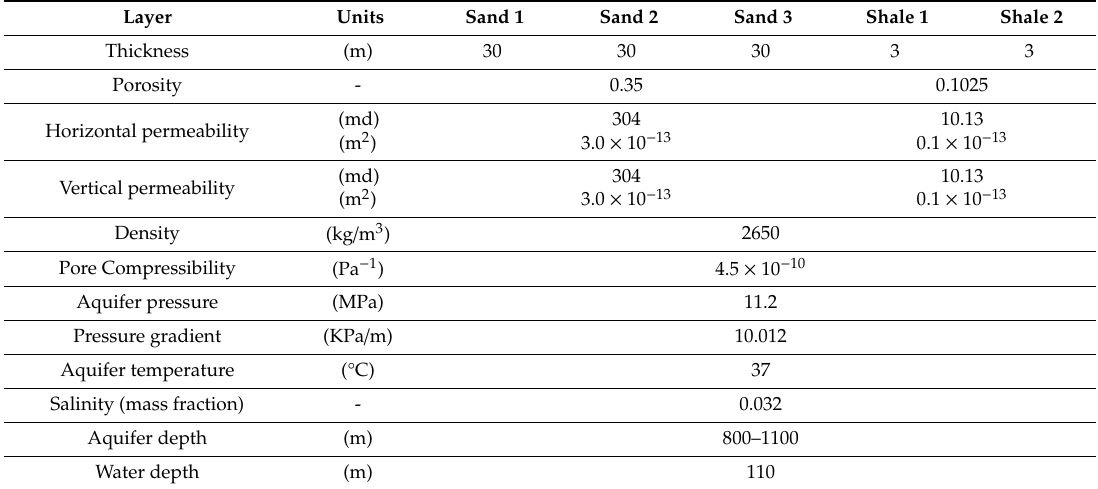
Table 1. Lithostratigraphic division and petrophysical parameters from Sleipner Vest Field, after [42]. These are model parameters used in this study; however, the developed methodology is generic and may be applied in other geological formations.